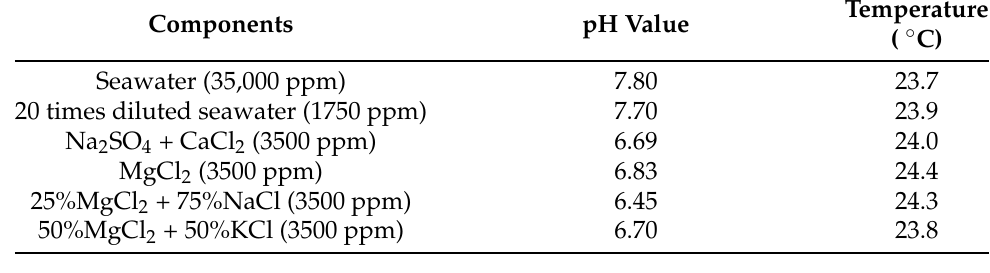
Table 8. Results of pH value for the six selected brine solutions at ambient conditions.